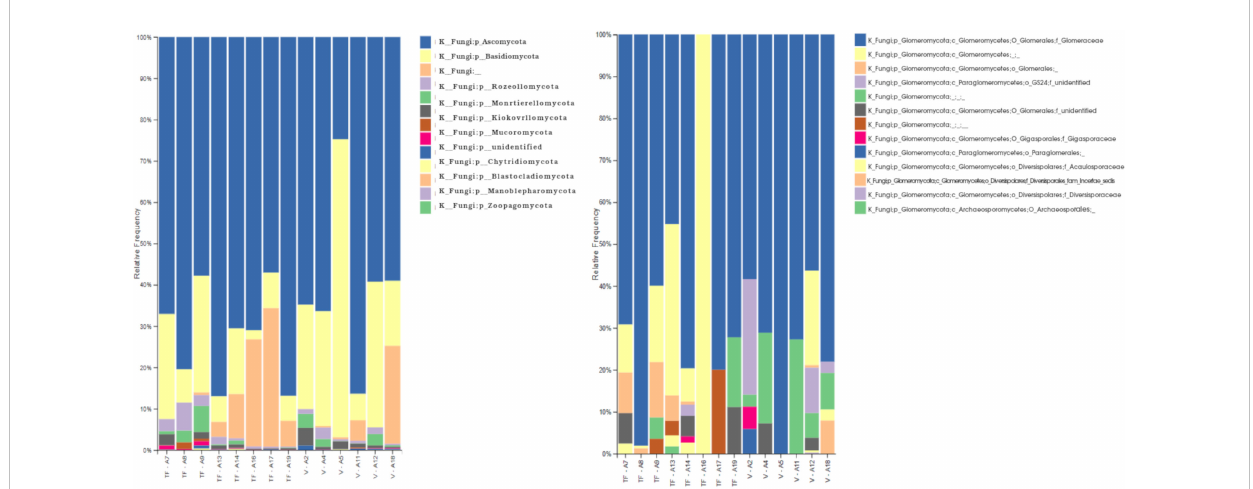
FIGURE 3 Results of ITS amplicon sequencing of rhizosphere soil samples of Inga seedlings collected in va ́ rzea (V) and terra fi rma (TF) ecosystems at the Tiputini Biodiversity Station in the pristine Ecuadorian Amazon. ITS sequences were analyzed using Qiime2. Left panel bar plot representing speci fi c ASVs annotated to the Fungi kingdom; Right panel barplot representing ASVs belonging to the subphylum Glomeromycotina (formerly known as the phylum Glomeromycota).